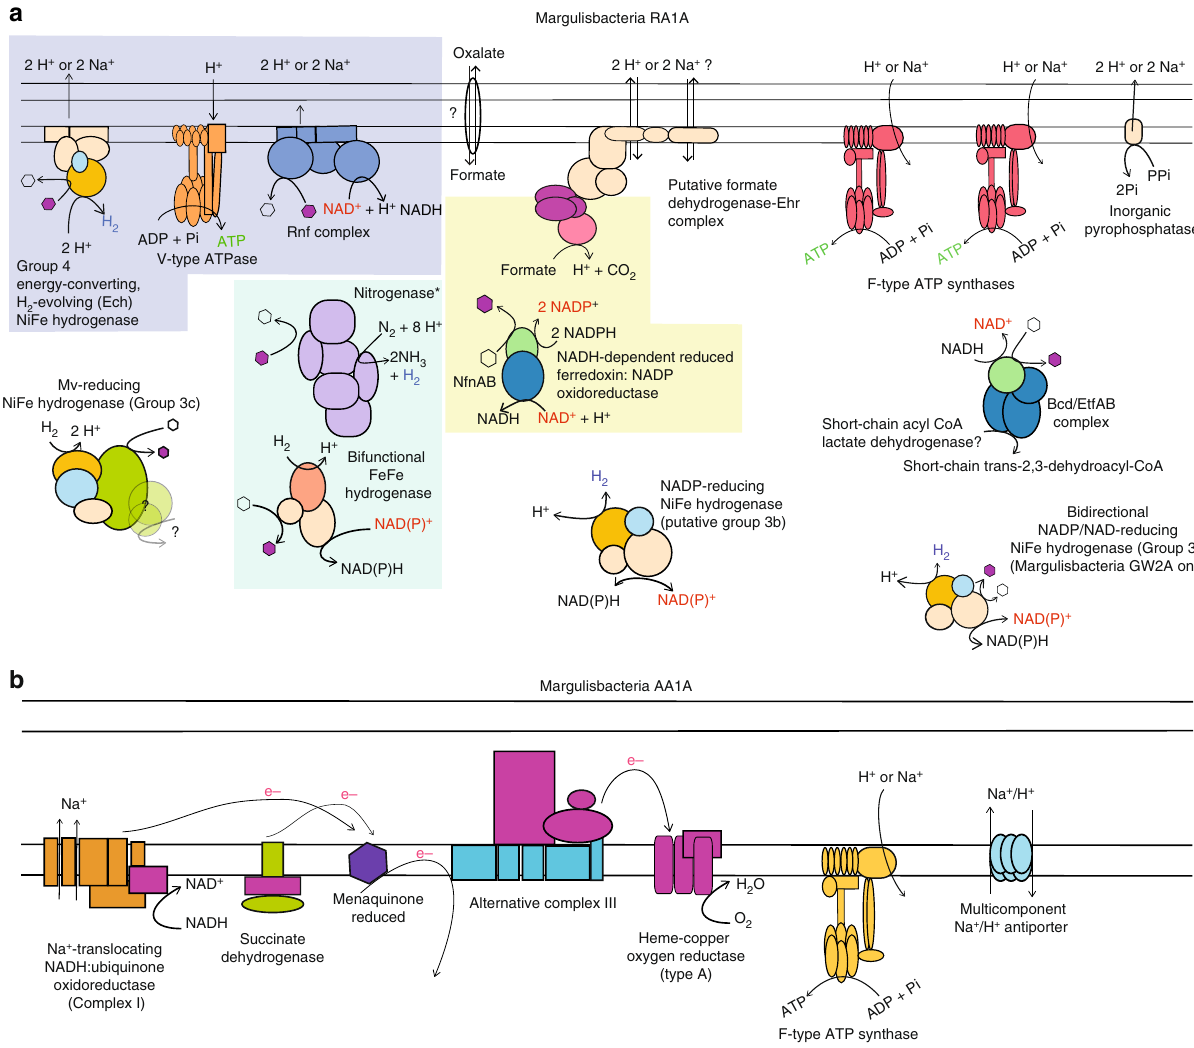
Fig. 3 Schematic view of key protein complexes involved in energy metabolism. a Cytoplasmic and membrane bound hydrogenases, membrane-bound hydrogenase-related complex, ATPases, and electron bifurcating complexes in Margulisbacteria RA1A, representative of Ri fl emargulisbacteria. b Electron transport chain in Margulisbacteria AA1A, representative of Marinamargulisbacteria. Protein complexes encoded by genes in the same genomic region in the RA1A genome are highlighted as follows: the Ech NiFe hydrogenase, the V-type ATPase, and the Rnf complex in purple; the nitrogenase and the FeFe hydrogenase in blue; and the putative FDH and the Nfn complex in